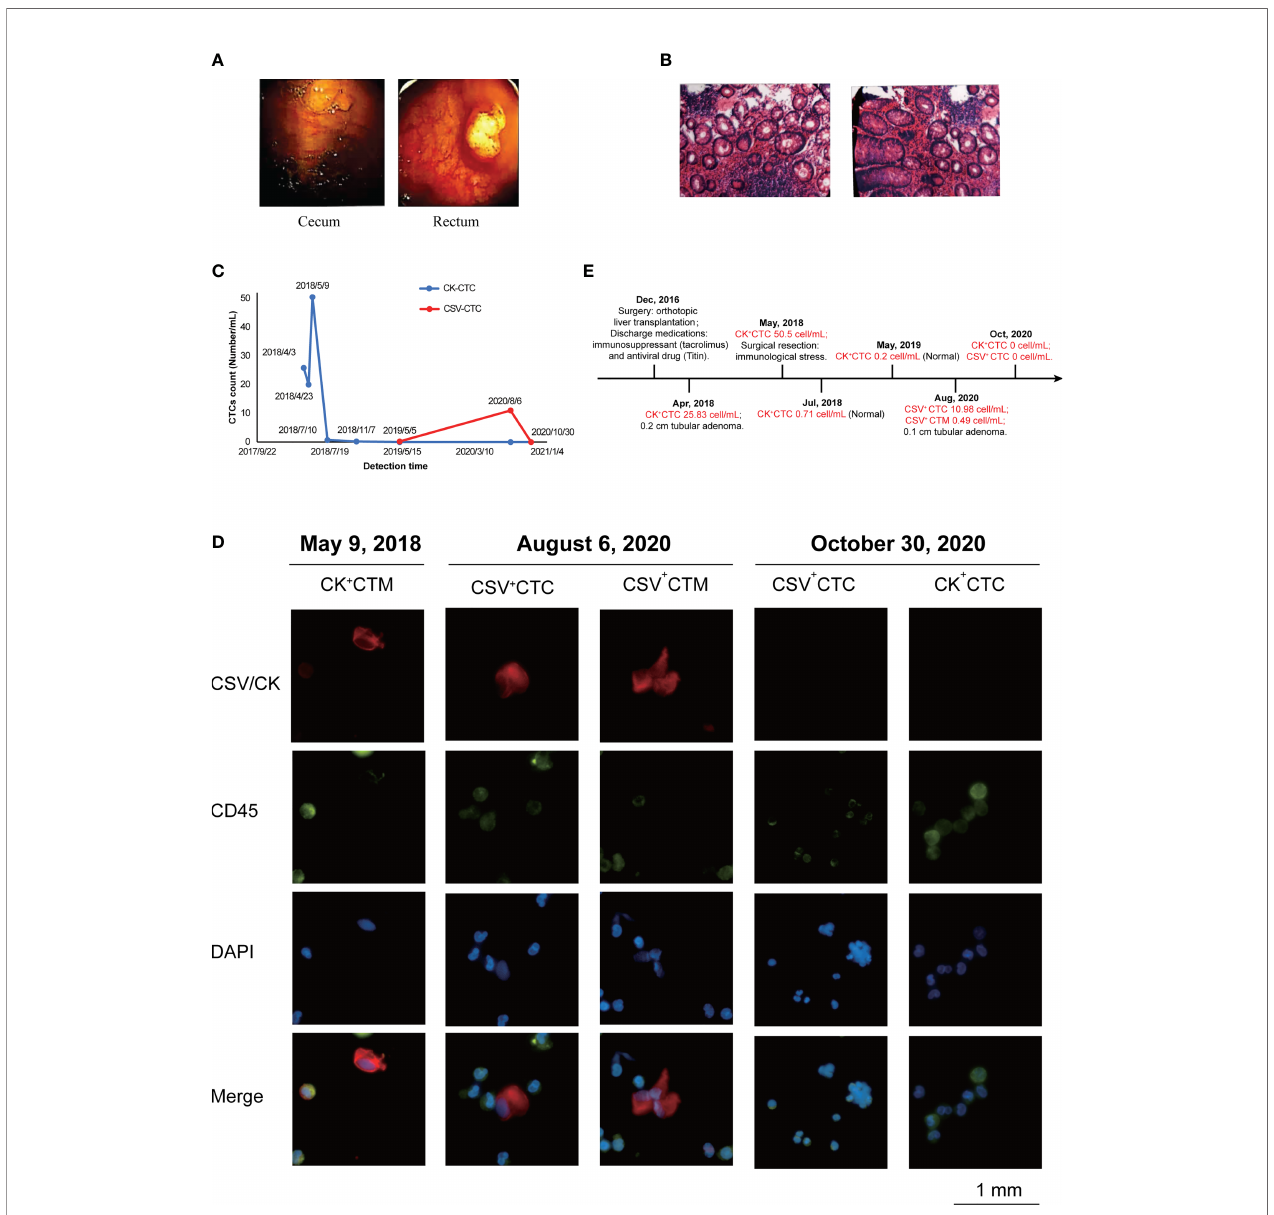
FIGURE 1 | Monitoring CTC count to track HCC progression after liver transplantation. (A) Electronic colonoscopy of the cecum and rectum in April 2018. Images revealed a spherical subpedicle polyp of about 0.6cm x 0.8cm in size in the cecum, with a smooth surface; and 8cm away from the anus, there are 2 polyps in the rectum, with the larger size of 2.0cm x 1.6cm. (B) Pathological biopsy observed under a microscope in August 2020. Images revealed under the light microscope, part of the epithelium showed mild to moderate atypical hyperplasia, with increased cell levels, but no clear malignant changes were seen. (C) Changes in circulating tumor cell (CTC) counts (number/mL) after metastasis. The summarizes results of CTC analysis in the present case from April 2018 to October 2020. The specimen showed the counts (number/mL) of CK+ CTCs changed from April 2018 to November 2018 obviously and then the counts (number/mL) of CSV+ CTCs also showed variations from May 2019 to October 2020. (D) Representative immuno fl uorescent images of CTCs obtained separately after blood analysis of the present case on May 9, 2018, August 6, 2020, and October 30, 2020, using Cellab Thomas I system (LABVIV, Shenzhen). CTCs were de fi ned as captured cells that were cytokeratin positive (CK+) or vimentin +, CD45-, and DAPI+. The cytokeratin positive (CK+) or vimentin + were stained as red color; CD45+ was stained as green color and DAPI+ was stained as blue color. (E) Treatment timeline of patient from December 2016 to October